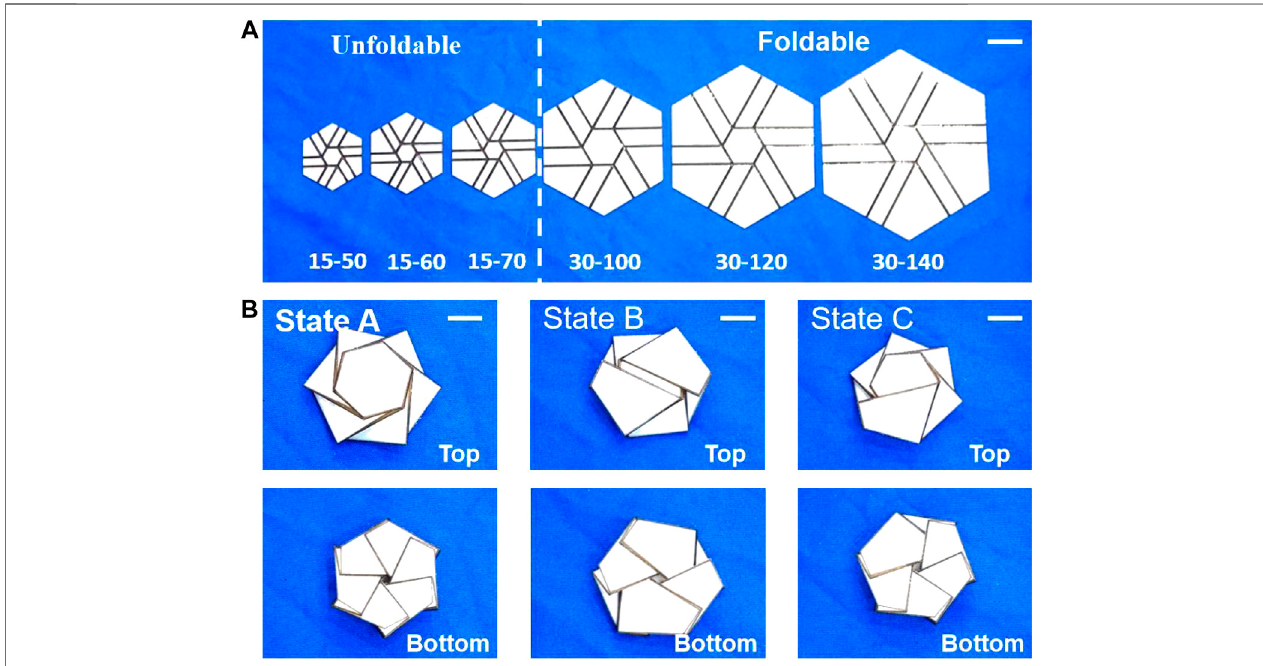
FIGURE4| Themulti-material3Dprintedhexagon-twistorigamistructure. (A) Multi-stableresearchabouthexagon-twistorigamistructurewithdifferentsize(h-H: h and H denotes the height of the inner and outer hexagon, respectively). Scale bar, 30 mm. (B) The multi-stable states of 3D printed hexagon-twist origami structure with size 30 – 100. Scale bar, 10